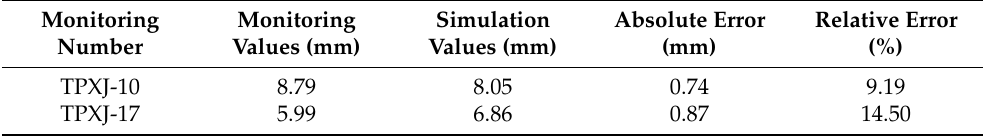
Table 4. Comparison of simulation results and field monitoring data for stage I of water impoundment. Monitoring